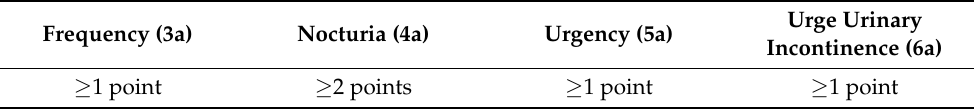
Table 1. Definitions of the urinary symptoms, OAB-dry, and OAB-wet. Frequency